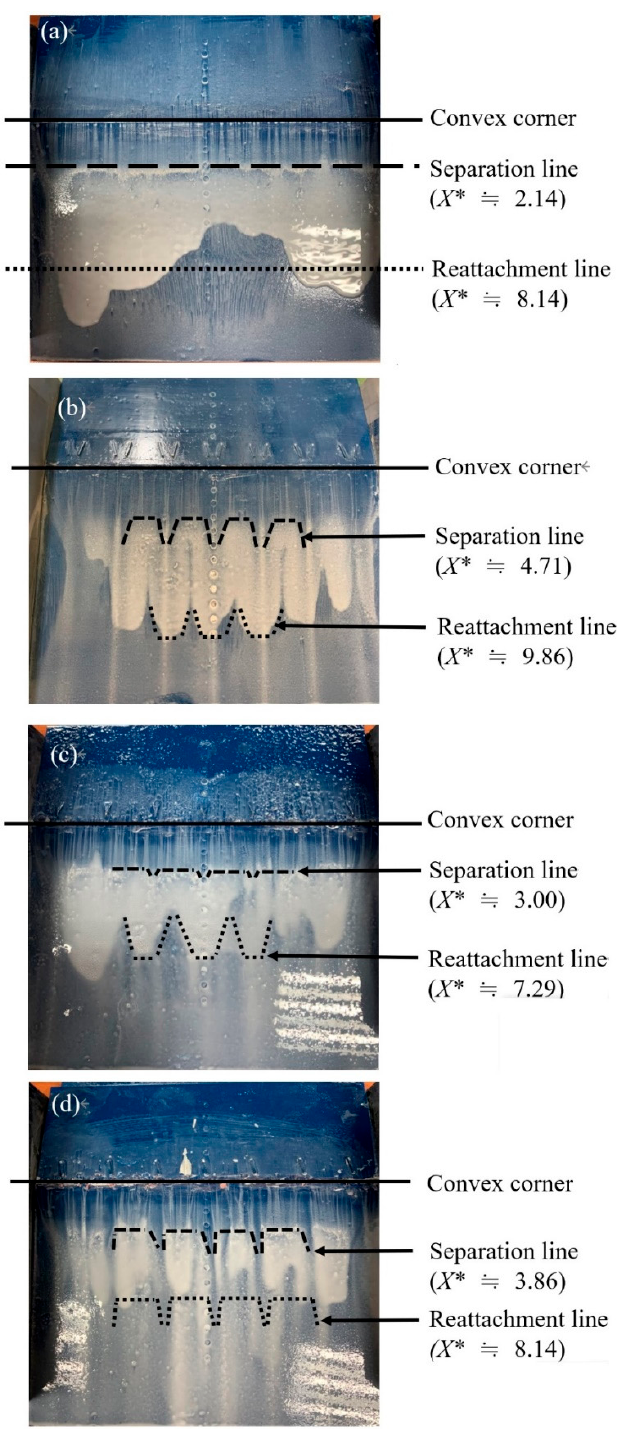
Figure 14. Surface oil flow visualization for η = 13° and M = 0.83: ( a ) no MVGs, ( b ) CRV type, ( c ) Ramp type and ( d ) Vane type.